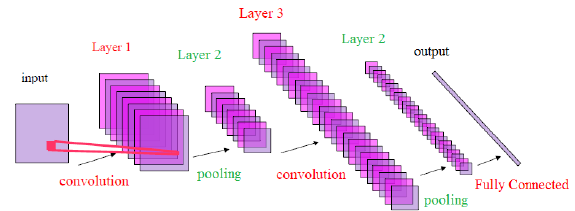
Figure 1. Architecture of LeNet-5, a CNN (Lecun, et al.,